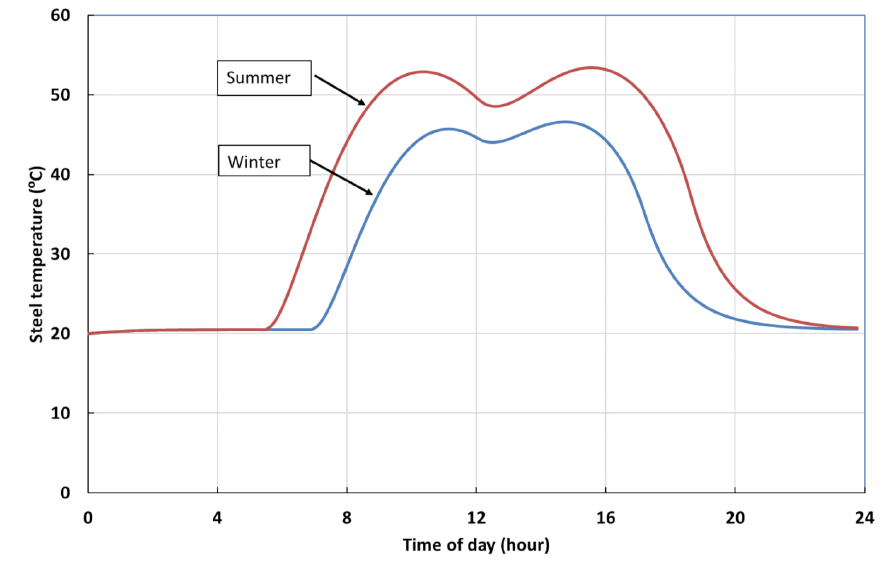
Figure 9. Steel container wall temperature for mid-summer and